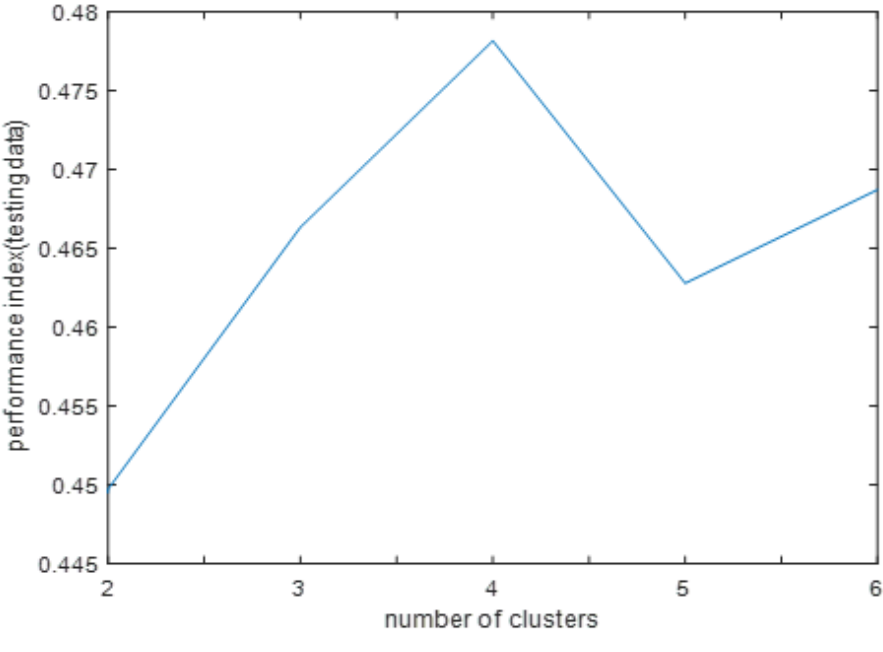
Figure 14. PI of the optimized CGK-based fuzzy granular model.